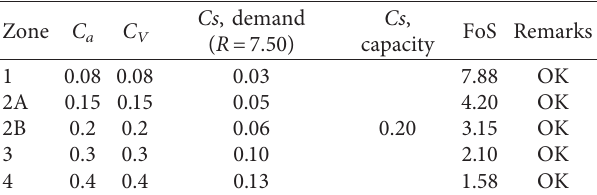
Table 3: Seismic performance of haunch retrofitted RC frame in various seismic